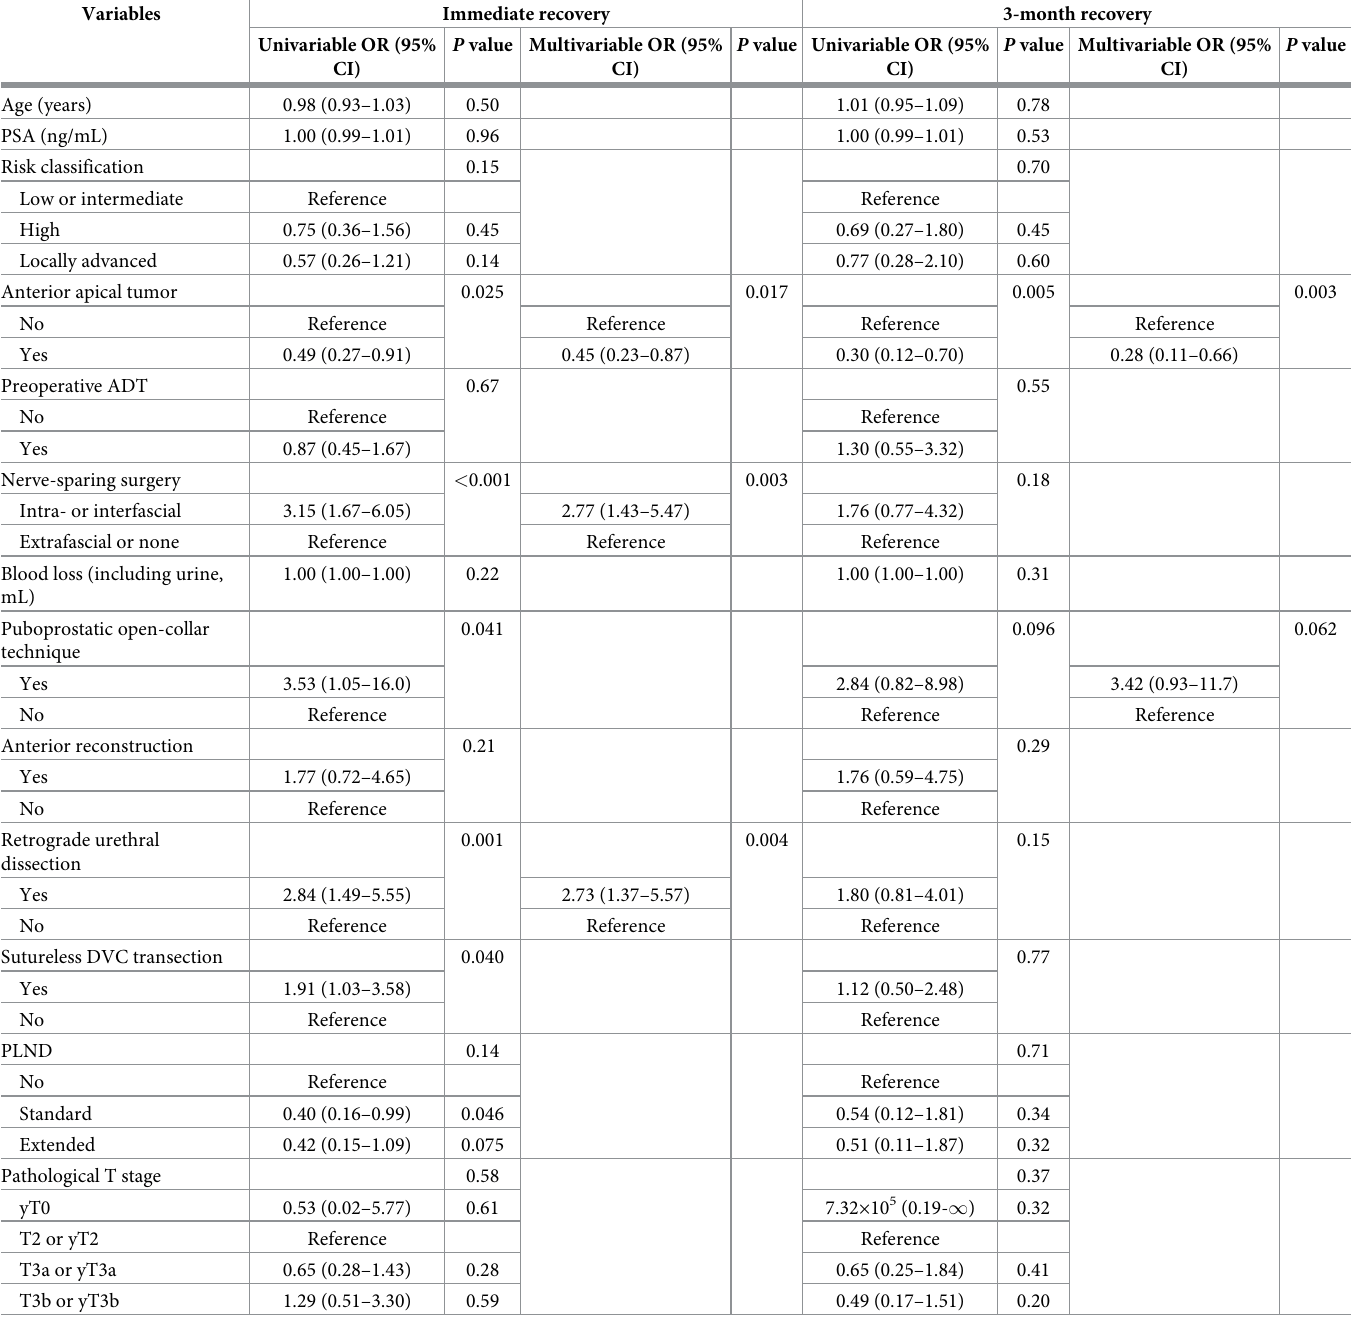
Table 4. Uni- and multivariable analysis for postoperative continence